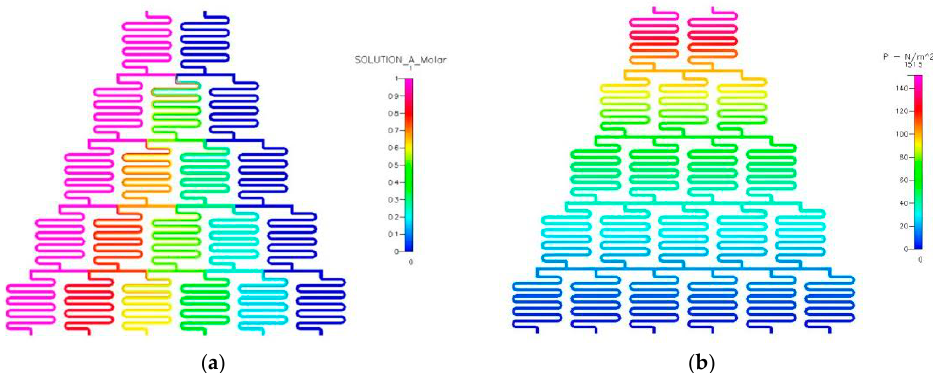
Figure 2. Simulation results by the CFD-VIEW for the analysis of concentration gradient and pressure distribution at 1.5 µL/min flow rate in the microchannel. ( a ) Concentration distribution in the microchannel with the highest concentration at the left and the lowest concentration at the right position; ( b ) Pressure distribution in the microchannel where pressure decreases as the solution traveled from the top to the bottom.